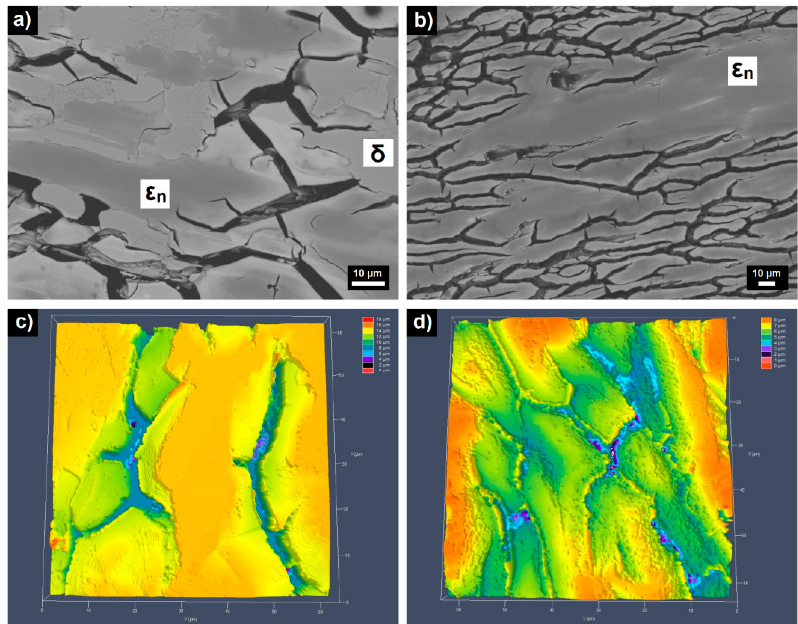
Figure 18. Microstructure of as-corroded Al–Pd–Co alloys: backscatter scanning electron microscopy images of Al 70 Pd 25 Co 5 ( a ) and Al 74 Pd 12 Co 14 ( b ) and confocal laser scanning images of Al 70 Pd 25 Co 5 ( c ) and Al 74 Pd 12 Co 14 ( d ). Reproduced from reference [107].